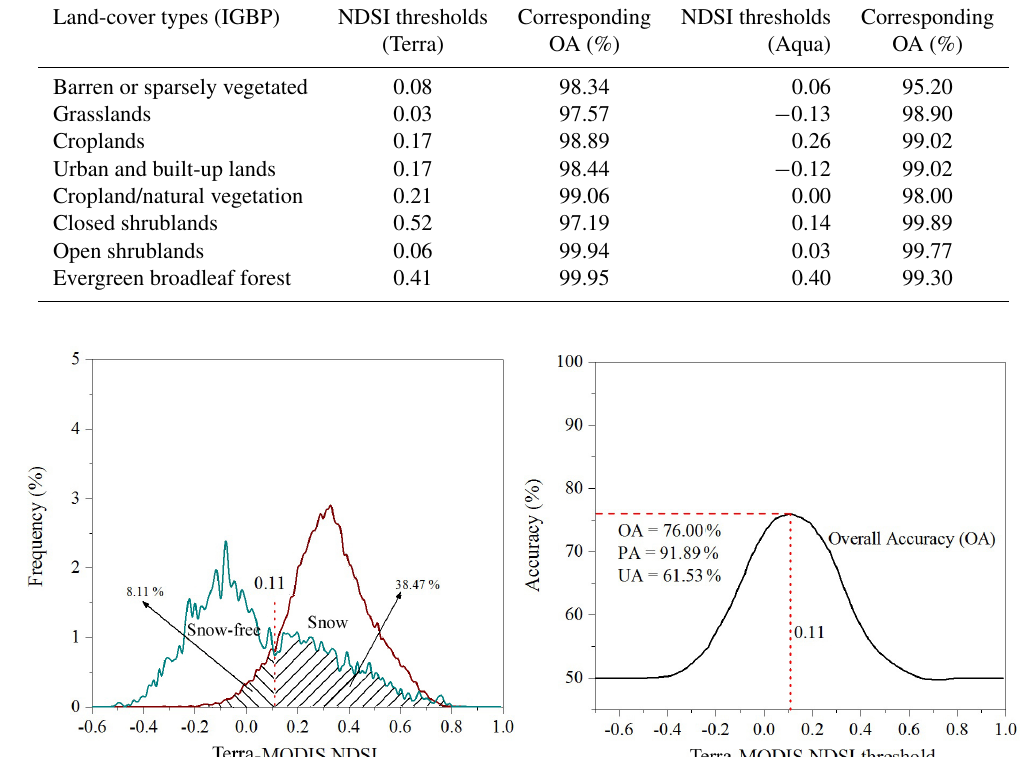
Figure 3. Optimal NDSI thresholds over the land-cover type of “evergreen needleleaf